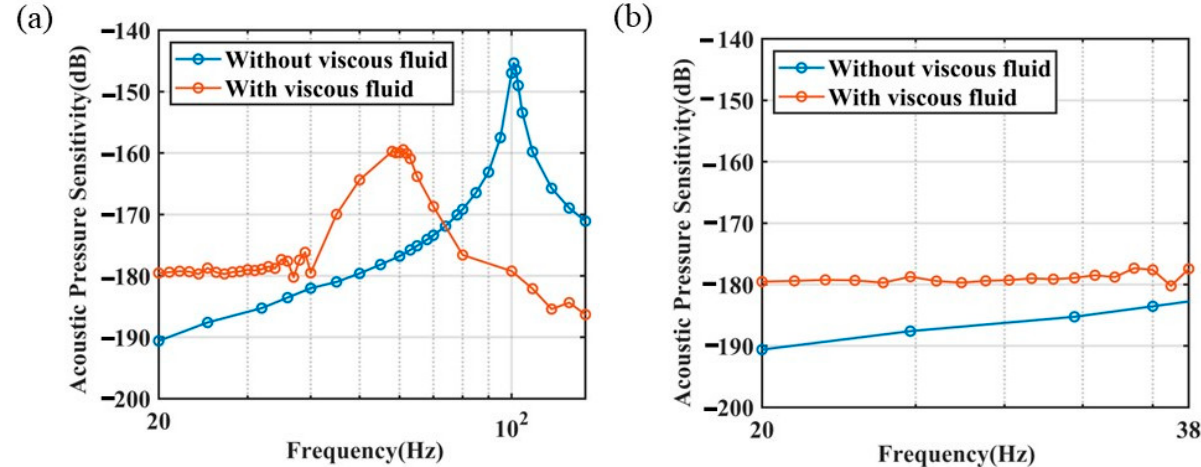
Figure 12. The phase sensitivity curve of the sensor. ( a ) 20–140 Hz; ( b ) 20–38 Hz.